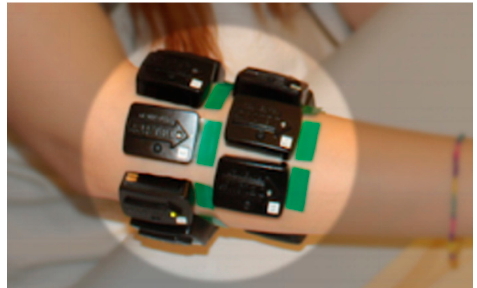
Figure 3. Positioning of EMG electrodes in the analyzed data (Ninapro DB6). Two arrays of electrodes were equally spaced on the forearm: the first array (in correspondence to the radio-humeral joint) included 8 electrodes, the second included